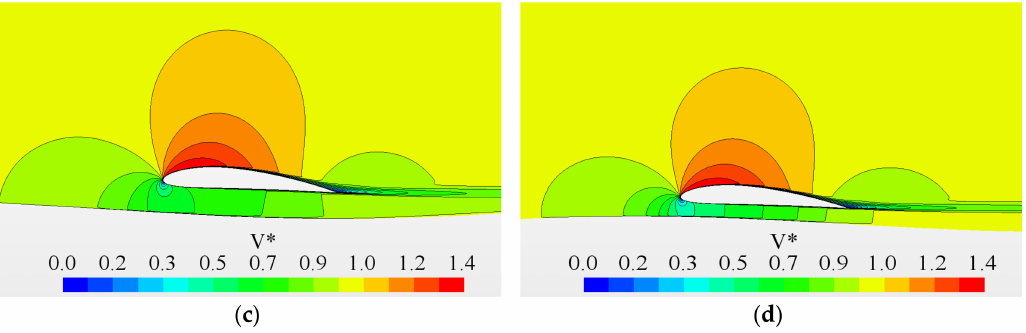
Figure 9. Velocity contours of di ff erent moments at α = 4 ◦ : ( a ) t* = 0.0, ( b ) t* = 0.25, ( c ) t* = 0.5, ( d ) t* = 0.75.